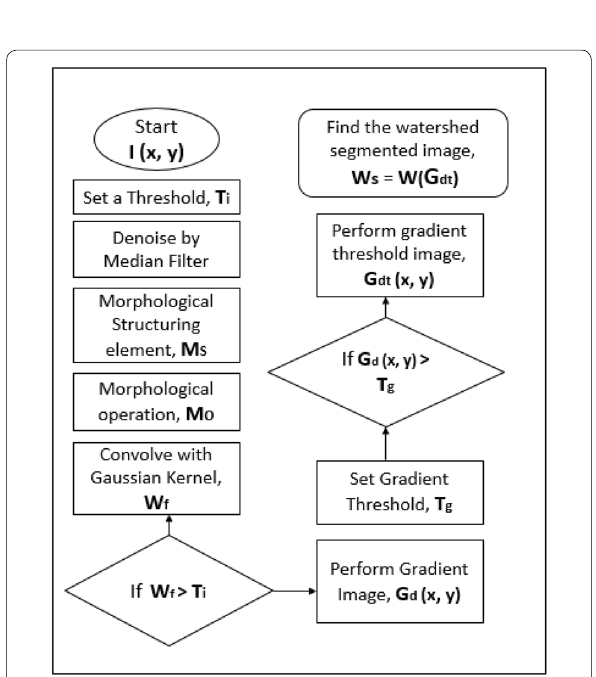
Fig. 5 Flowchart of segmentation process using watershed algorithm. The initiation is accomplished by filtration, and then, the watershed transform is performed